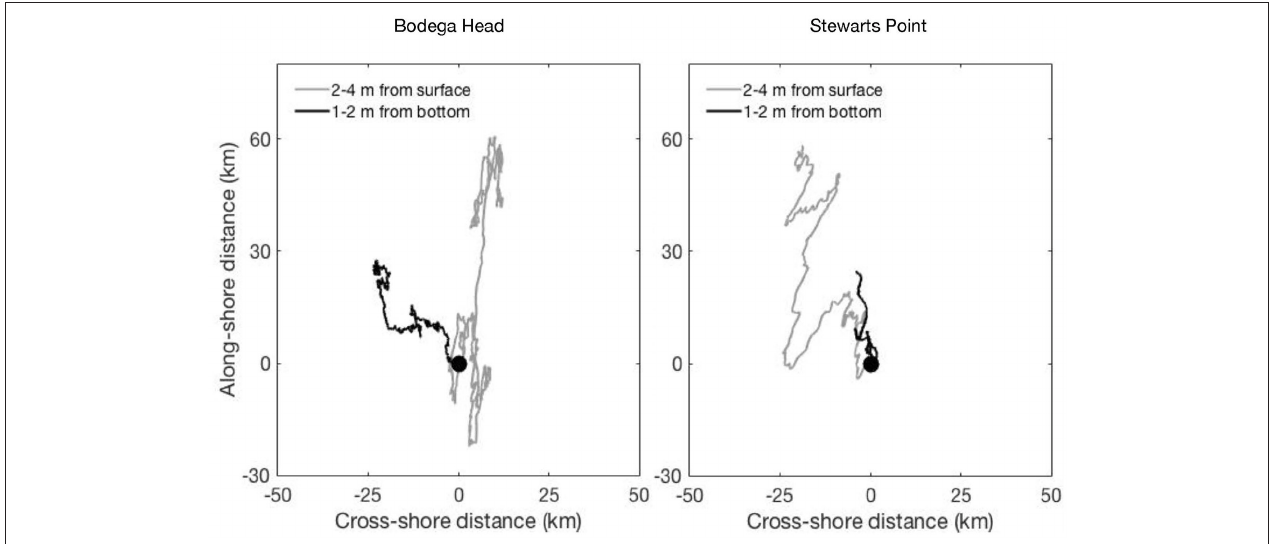
FIGURE 5 | Progressive vector diagrams of potential alongshore and cross-shore displacement due to currents measured near-surface (gray line) and near-bottom (black line) from mid 24 May through 26 July 2009 at Bodega Head and Stewarts Point. Current velocity was measured by a bottom-moored ADCP at 30-m depth at each site. Positive alongshore distances are poleward and positive cross-shore distances are